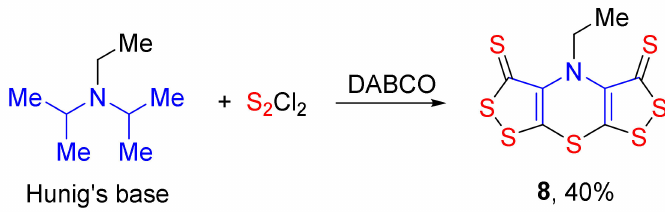
Scheme 17. Reaction of Hünig’s base with disulfur